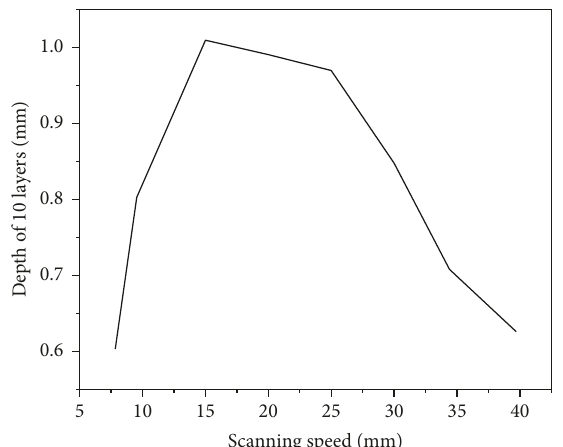
Figure 3: The relationship between scanning speed and engraving depth.